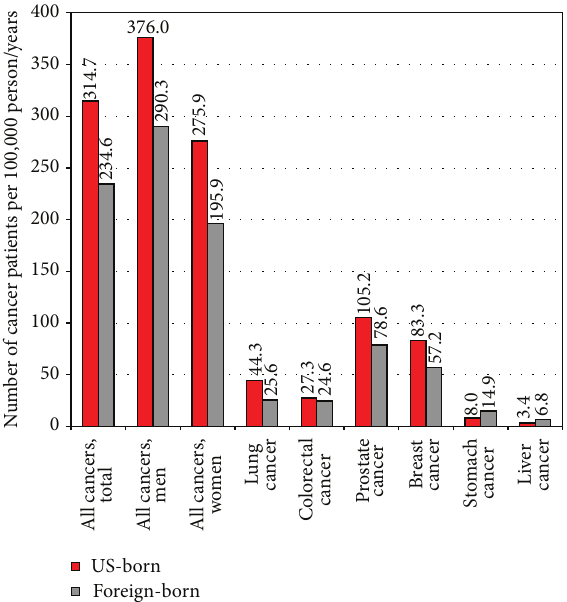
Figure 4: US cancer incidence rates by nativity/immigrant status: The US National Longitudinal Mortality Study Linked with 11 SEER Registries, 1980–1998. SEER: surveillance, epidemiology, and end results.Incidence rates areage-adjusted to the2000 US standard population. Differences in incidence rates between US-born and foreign-born individuals were statistically significant at the 0.05 level for all cancers combined, lung, prostate, breast, and stomach cancers. The 11 SEER registries include Iowa, Hawaii, Seattle, Connecticut, Detroit, Utah, Los Angeles, San Francisco/Oakland/San Jose/Monterey, Greater California, Louisiana, and